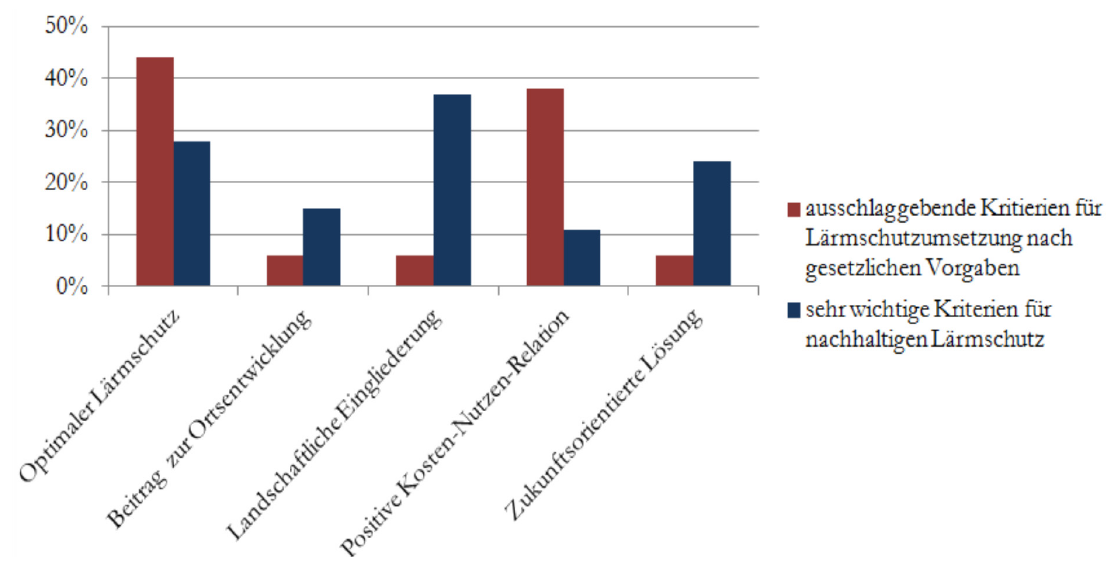
Figure 5: Criteria for noise protection according to legal requirements in comparison with criteria for sustainable noise protection according to experts (N = 15)